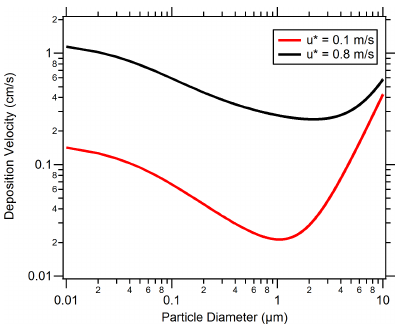
Figure 8. Particle dry deposition velocity resistance model results plotted by particle diameter and friction velocity. Two test cases of low and high friction velocity, representative of data collected at the PROPHET site, are plotted in solid red and black lines, respec- tively. Land-use conditions and seasonal parameters similar to those of the PROPHET campaign were used as inputs to the particle dry deposition model. Additional model parameters are provided in the Supplement.